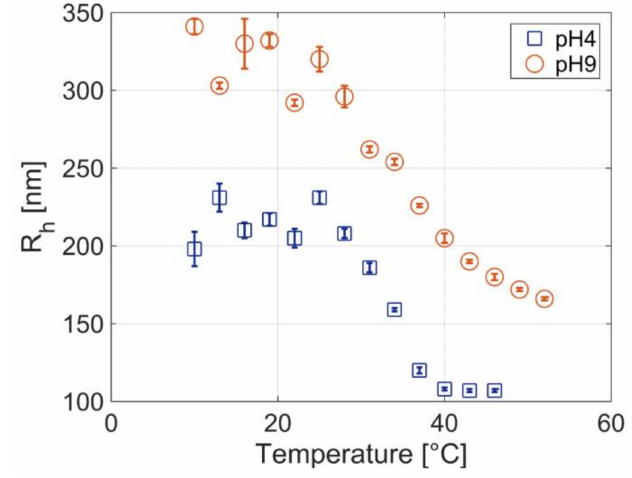
Figure 1. Dynamic Light Scattering (DLS) measurements of PNIPAm-co-AAc MGs at pH4 (blue squares) and pH9 (orange circles) as a function of